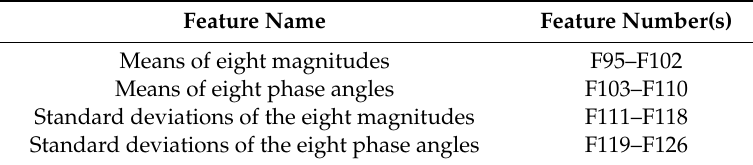
Table 10. Fourier features—local Fourier coe ffi